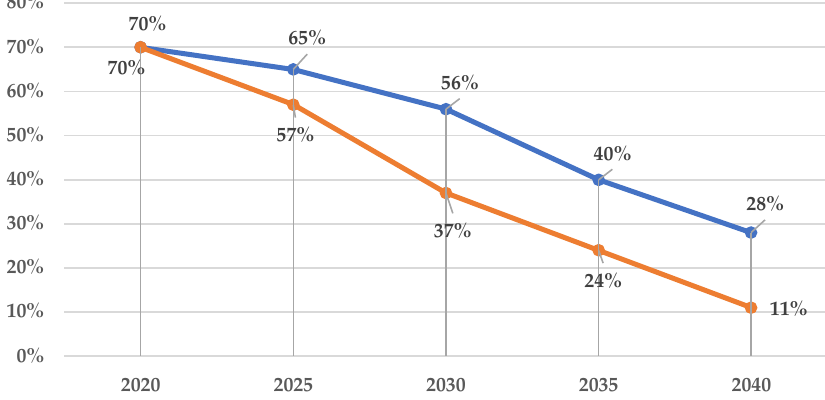
Figure 3. Forecast of the share of coal in electricity production until 2040 according to two scenarios [53].